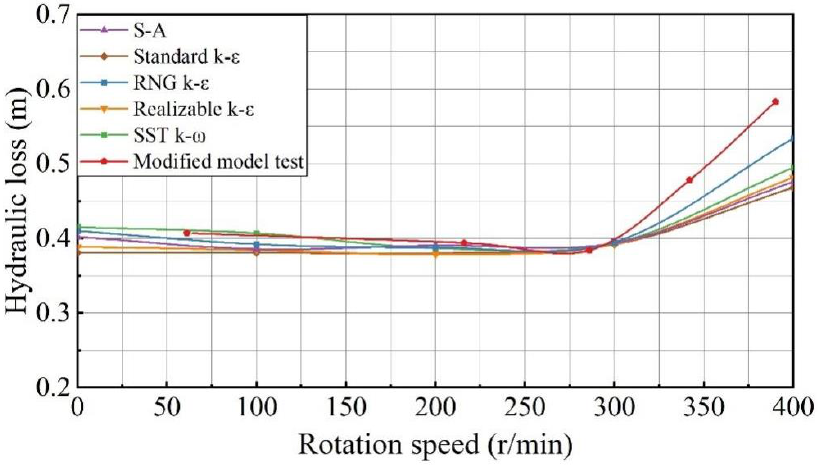
Figure 6. Comparison of hydraulic loss between numerical simulation (five different turbulent models) and model test.